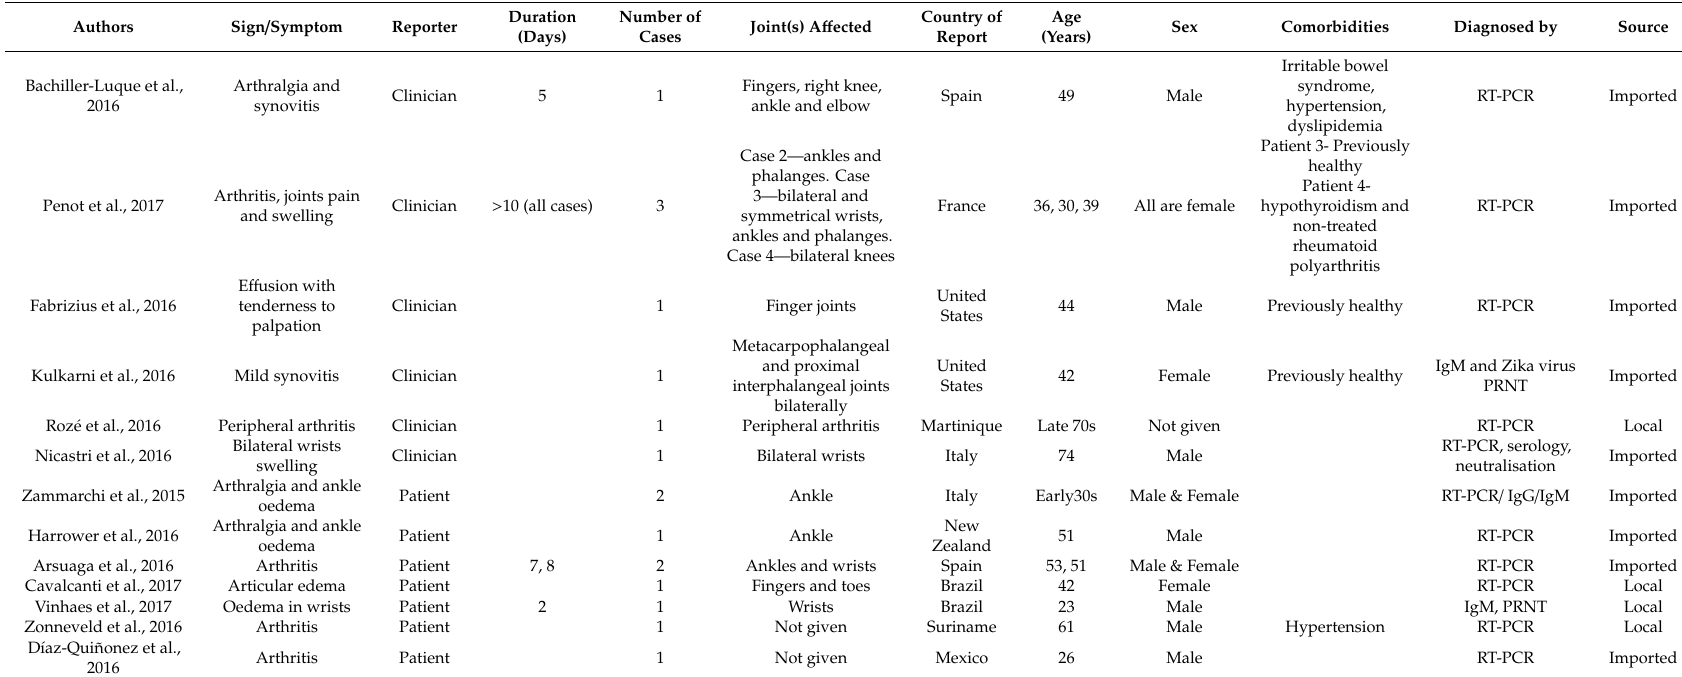
Table 4. Case studies reporting